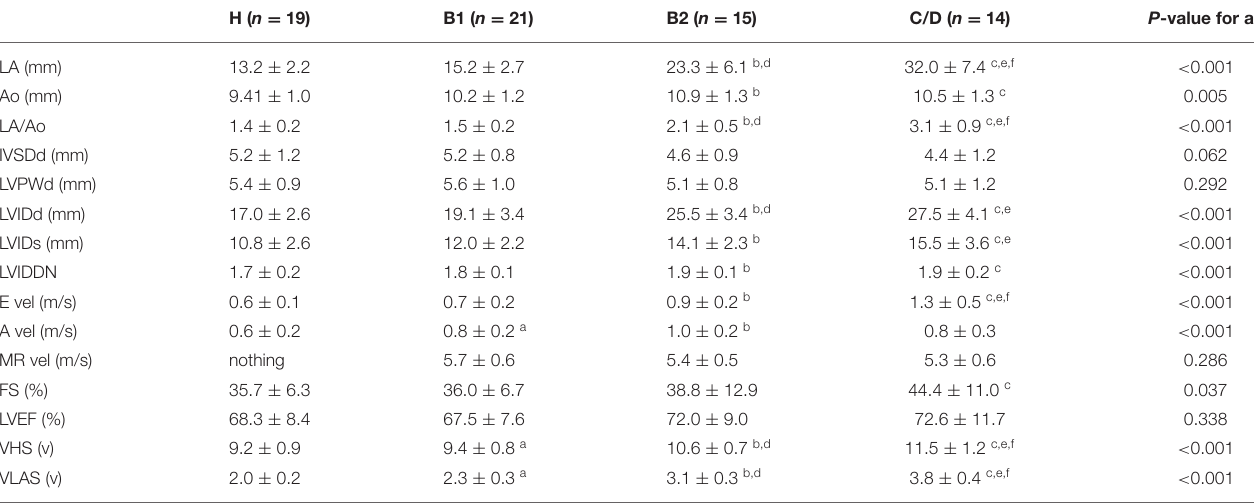
TABLE 3 | Echocardiographic and radiographic data in healthy Chihuahuas (H) and Chihuahuas with myxomatous mitral valve disease divided into three groups (B1, B2, and C/D). H ( n = 19) B1 ( n = 21) B2 ( n = 15) C/D ( n = 14) P -value for